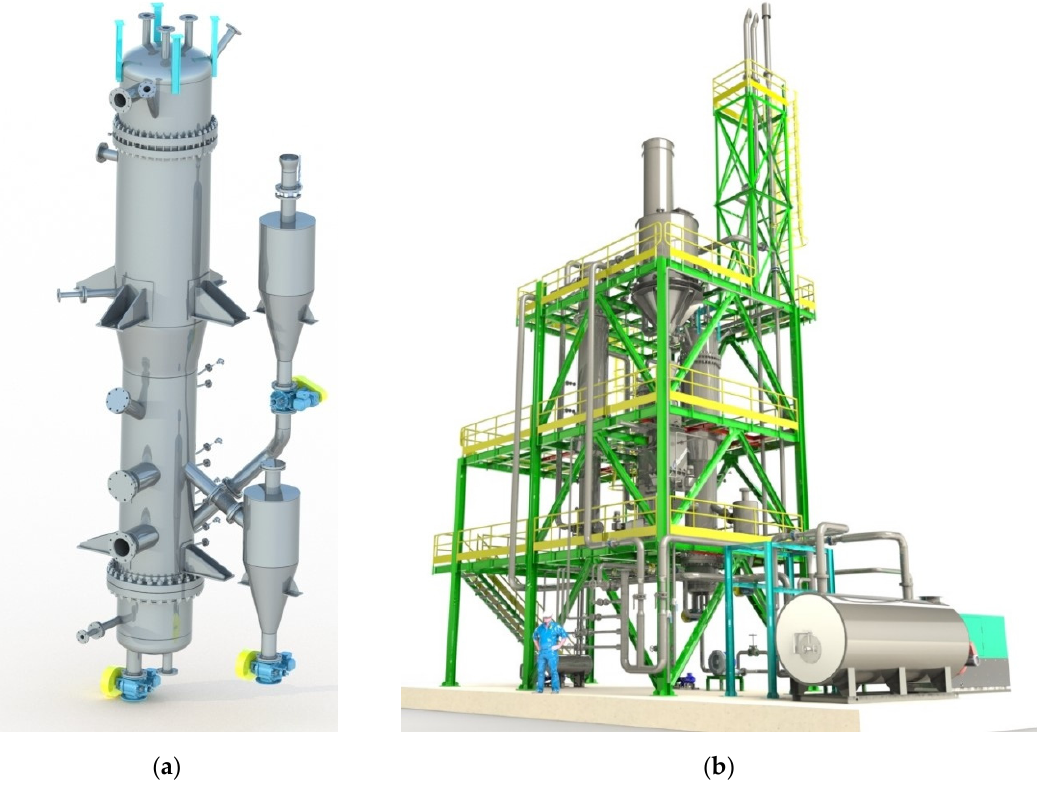
Figure 1. ENEA’s 1 MWth Internally Circulating Bubbling Fluidized Bed (ICBFB) pilot plant: ( a ) Gasifier details; ( b ) Whole pilot plant layout: it is visible the biomass feeding system, the gasifier, the heat exchanger and the syngas cleaning system.